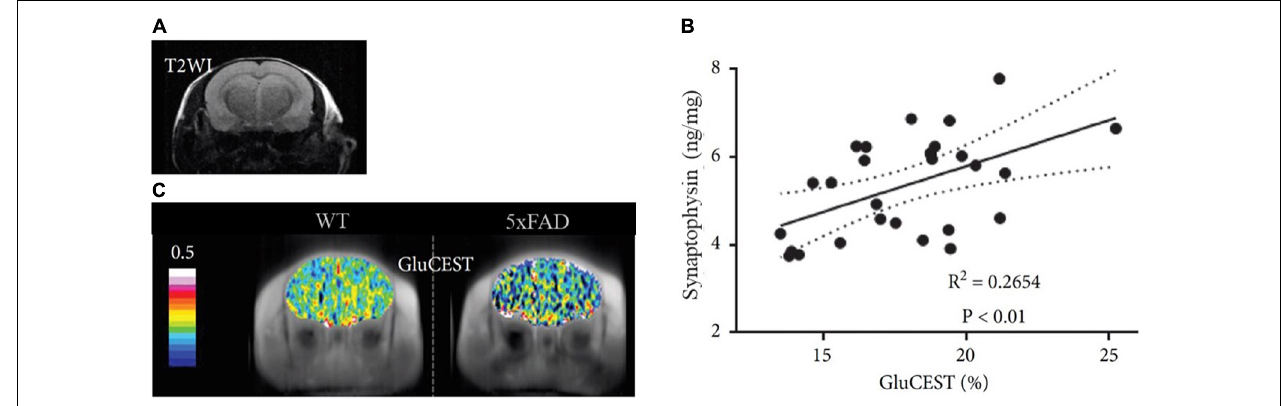
FIGURE 5 | Representative images of GluCEST MRI of a 5xFAD and a WT mouse. (A) Structural T2-weighted image (T2WI) in the coronal plane. (B) GluCEST maps of the corresponding T2WI showing reduced GluCEST effects in an aged (7-month old) 5xFAD mouse compared with the WT. (C) Correlation between GluCEST and Synaptophysin concentration. Figure extracted and modified from Igarashi et al.